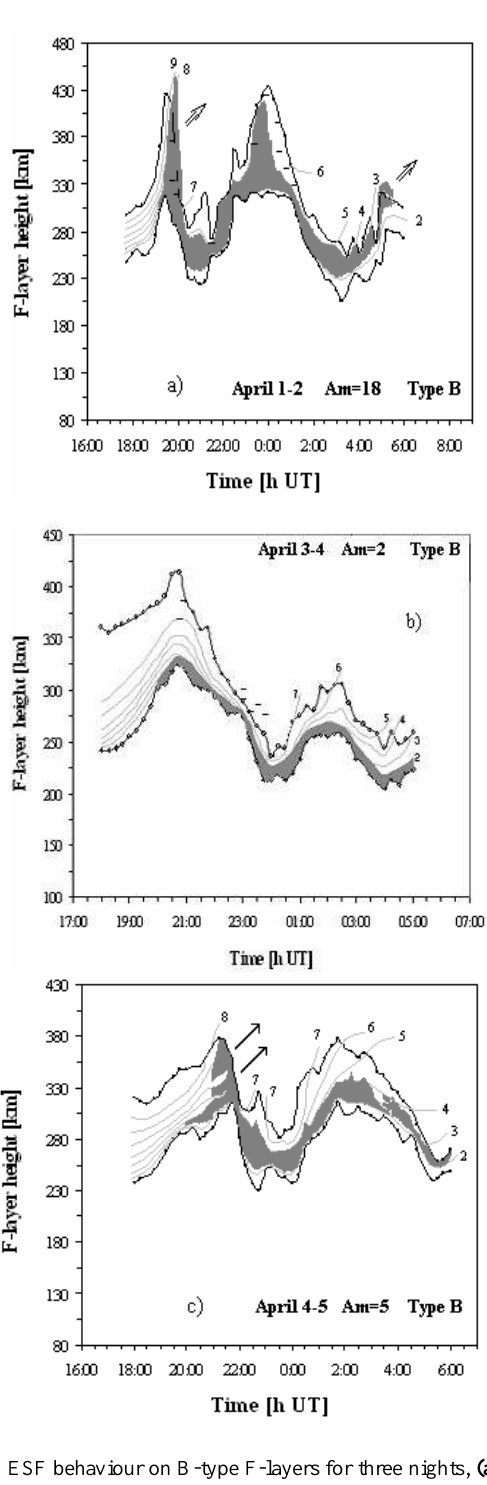
Fig. 8. ESF behaviour on B-type F-layers for three nights, (a) 1–2 April, (b) 3–4 April and (c) 4–5 April. The dashes correspond to the R-type ESF (range-spread) patterns. Note that the transition from the b-type ESF (bottom-spread) to the P-type one (F-layer peak- spread) is abrupt in 1–2 April but progressive in 4–5